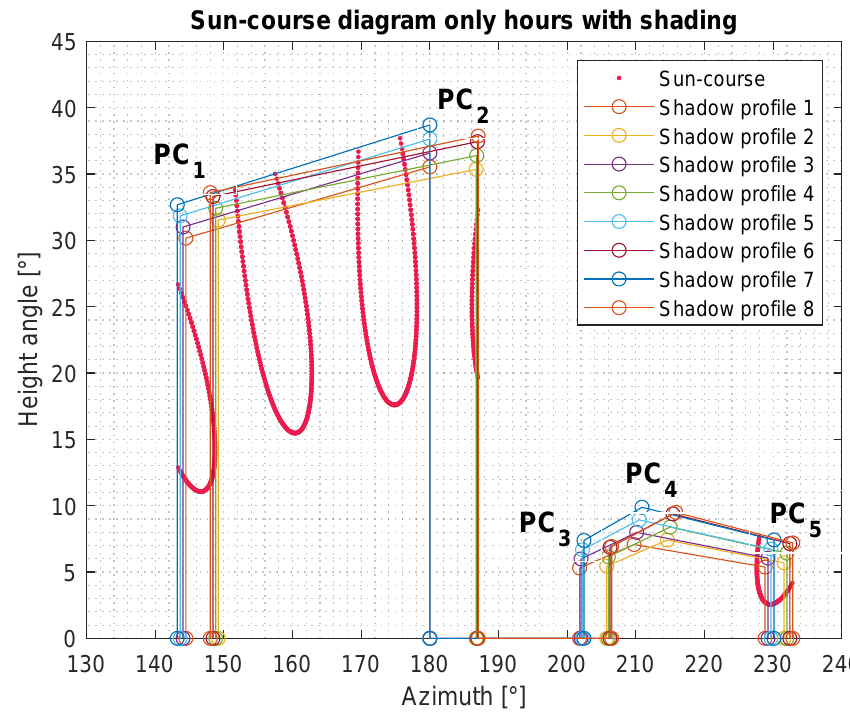
Figure 9. Hours with shading on the